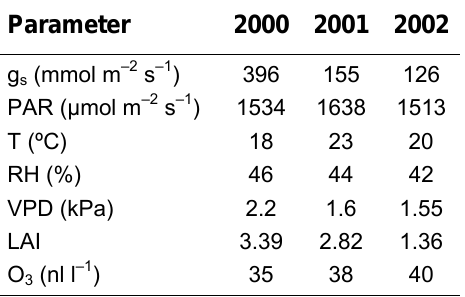
Mean Stomatal Conductance (g and Environmental Parameters